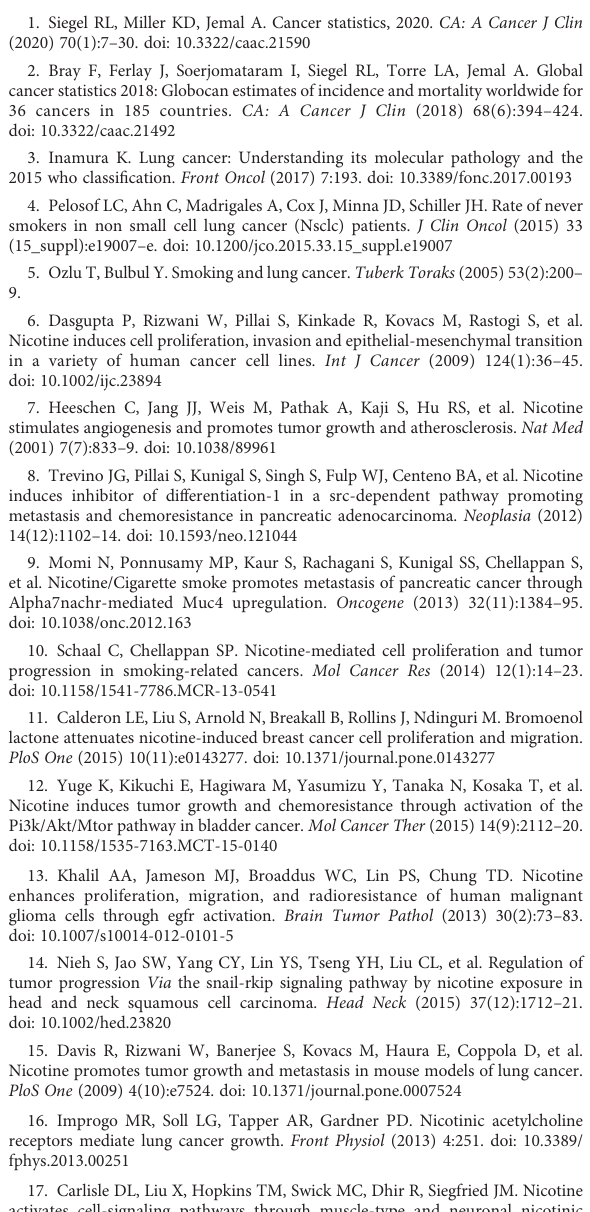
SUPPLEMENTARY FIGURE 1 Pearson ’ s correlation analysis was performed to analyze the correlation between PD-L1 (CD274), DRD2, CHRNA5, CHRNA7, and CHRNA9 mRNA expression from TCGA-LUAD database. SUPPLEMENTARY FIGURE 2 A schematic diagram depicting plausible connection between nAChR, DRD2, and PD-L1. Both nAChR and DRD2 activation by their respective ligands induce PD-L1 expression via STAT3 signaling mechanism. However, it is not clear how nAChRs are involved in peripheral DRD2 signaling, although they are known to be involved in dopamine synthesis in the brain. Created with